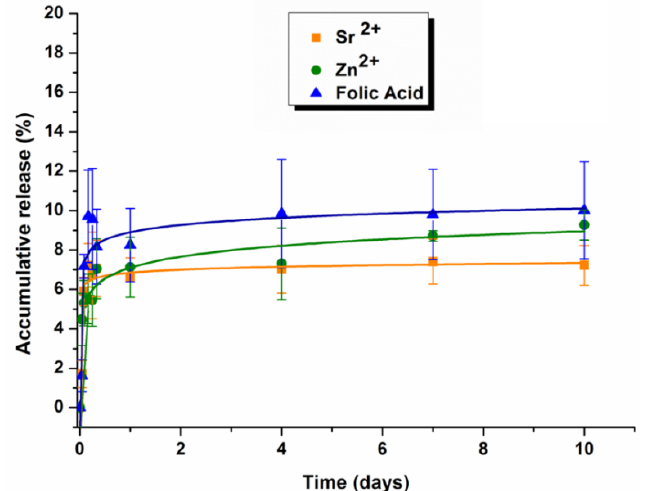
Figure 5. Sr 2 + and Zn 2 + and folic acid cumulative release profile from biomimetic scaffolds after 10 days of immersion in PBS of pH 7.4, at 37 °C, as determined by UV- absorbance and ICP-OES. Lines are a guide to the